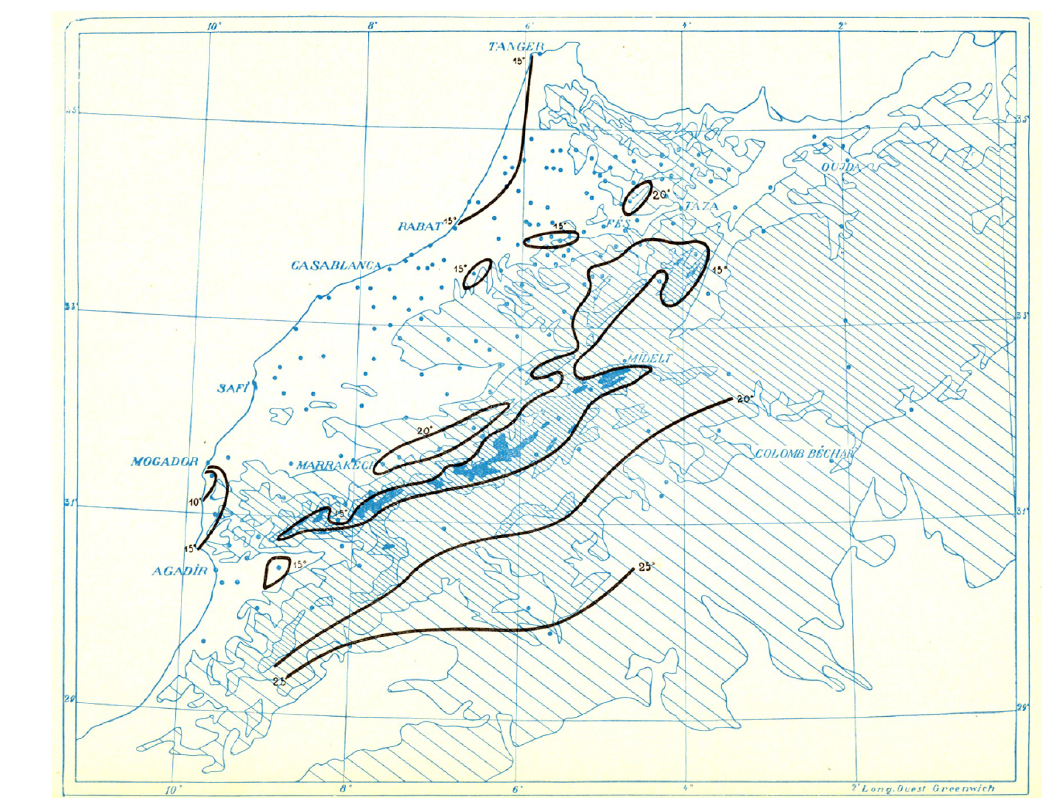
Figure 4. An example of the first meteorological maps prepared by the SPGM in 1934, showing the meteorological network of stations (dots) and the isotherms of the July minimum mean